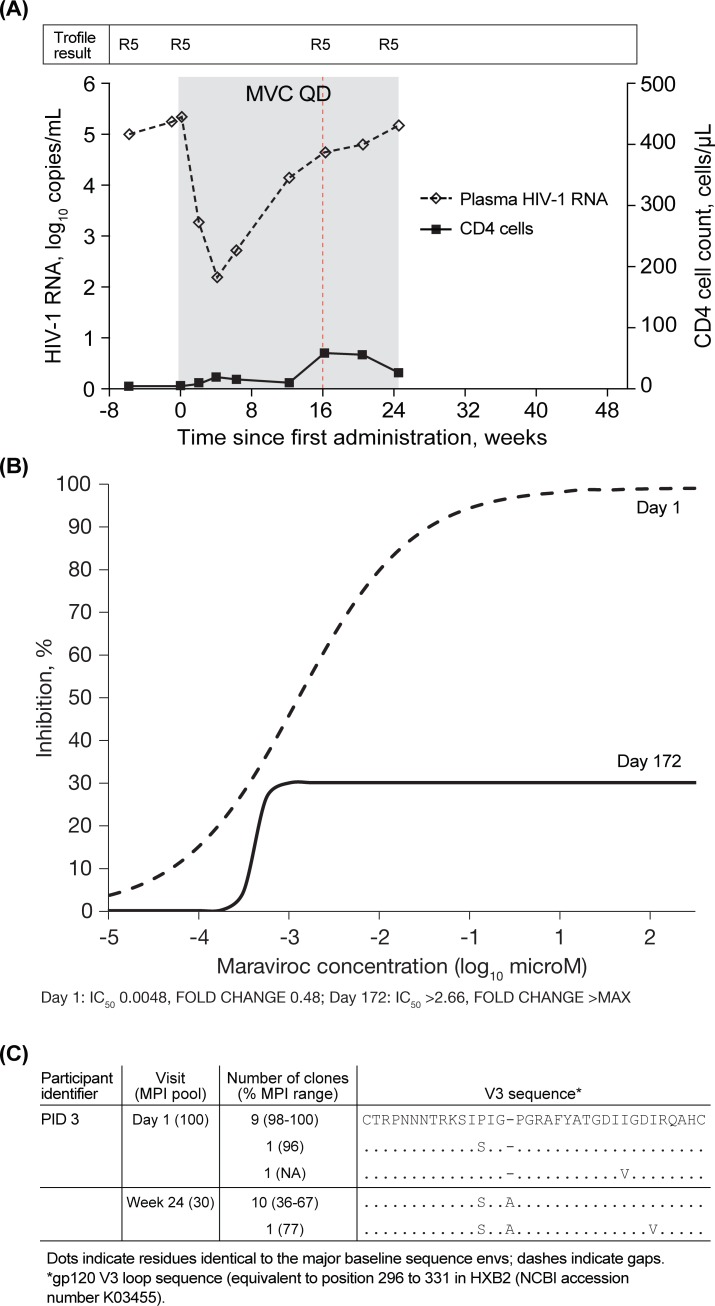
Example of failed maraviroc-containing treatment with R5 virus showing a plateau in MPI (indicates resistance).(A) Change in viral load (◊ dashed line) and CD4 (▪ solid line) for participant 3, who received maraviroc in combination with emtricitabine (FTC), atazanavir (ATV), and enfuvirtide (ENF) for 24 weeks (shaded area) and failed therapy at Week 16 (red vertical dotted line) with R5 virus. Regimen prior to Day 1: none. OBT from Day 1: FTC, ATV, ENF. Screening: FTCres, ATVres, ENFsens. Failure: FTCres, ATVres, ENFres (V38E). (B) The dose-response curves obtained in the PhenoSense Entry assay at Day 1 and at Day 172 (the last on-treatment time point). On Day 1, the dose-response curve reaches >95% inhibition and an IC50 can be calculated. On day 172, the dose-response curve plateaus at 30%, indicating resistance to maraviroc. (C) V3 sequence alignments for clones tested at Day 1 and Week 24. MPI, maximal percent inhibition; MVC, maraviroc; OBT, optimized background treatment; QD, once daily; R5, CCR5-tropic virus.